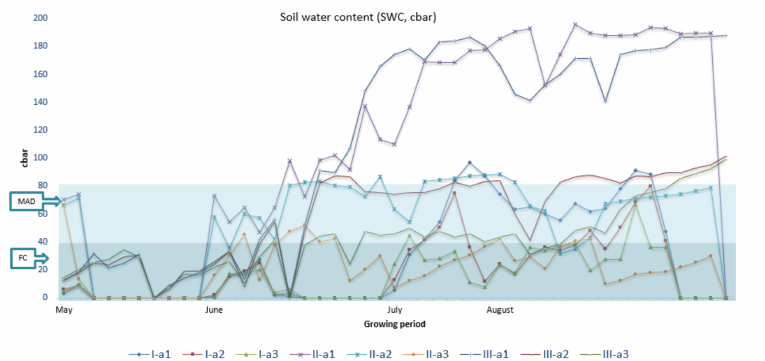
Figure 4. Soil water content (SWC, cbar) for the irrigation treatments (a1, a2, and a3) during the three-year study (I = extremely wet, II = extremely dry, III = average).